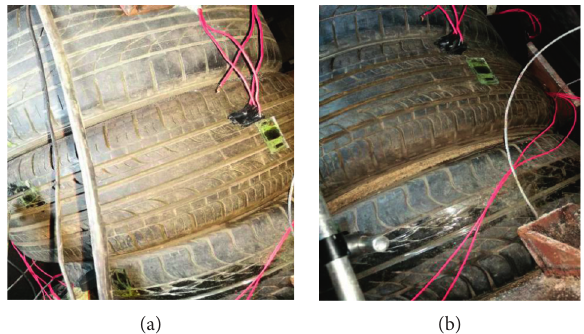
Figure 12: Failure state of specimen SD-2. (a) Misalignment between tires. (b) Sand leakage.